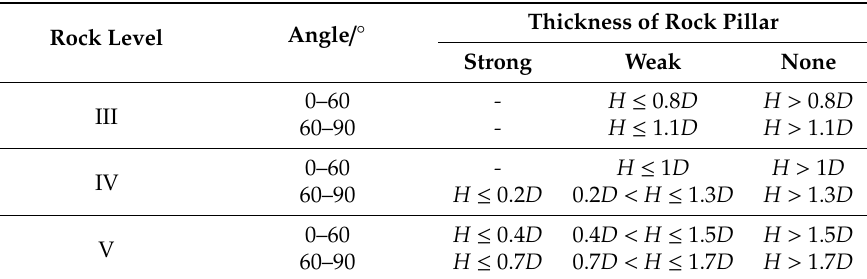
Table 11. Influence zoning of HSR cross tunnels for train speed = 300 km / h.